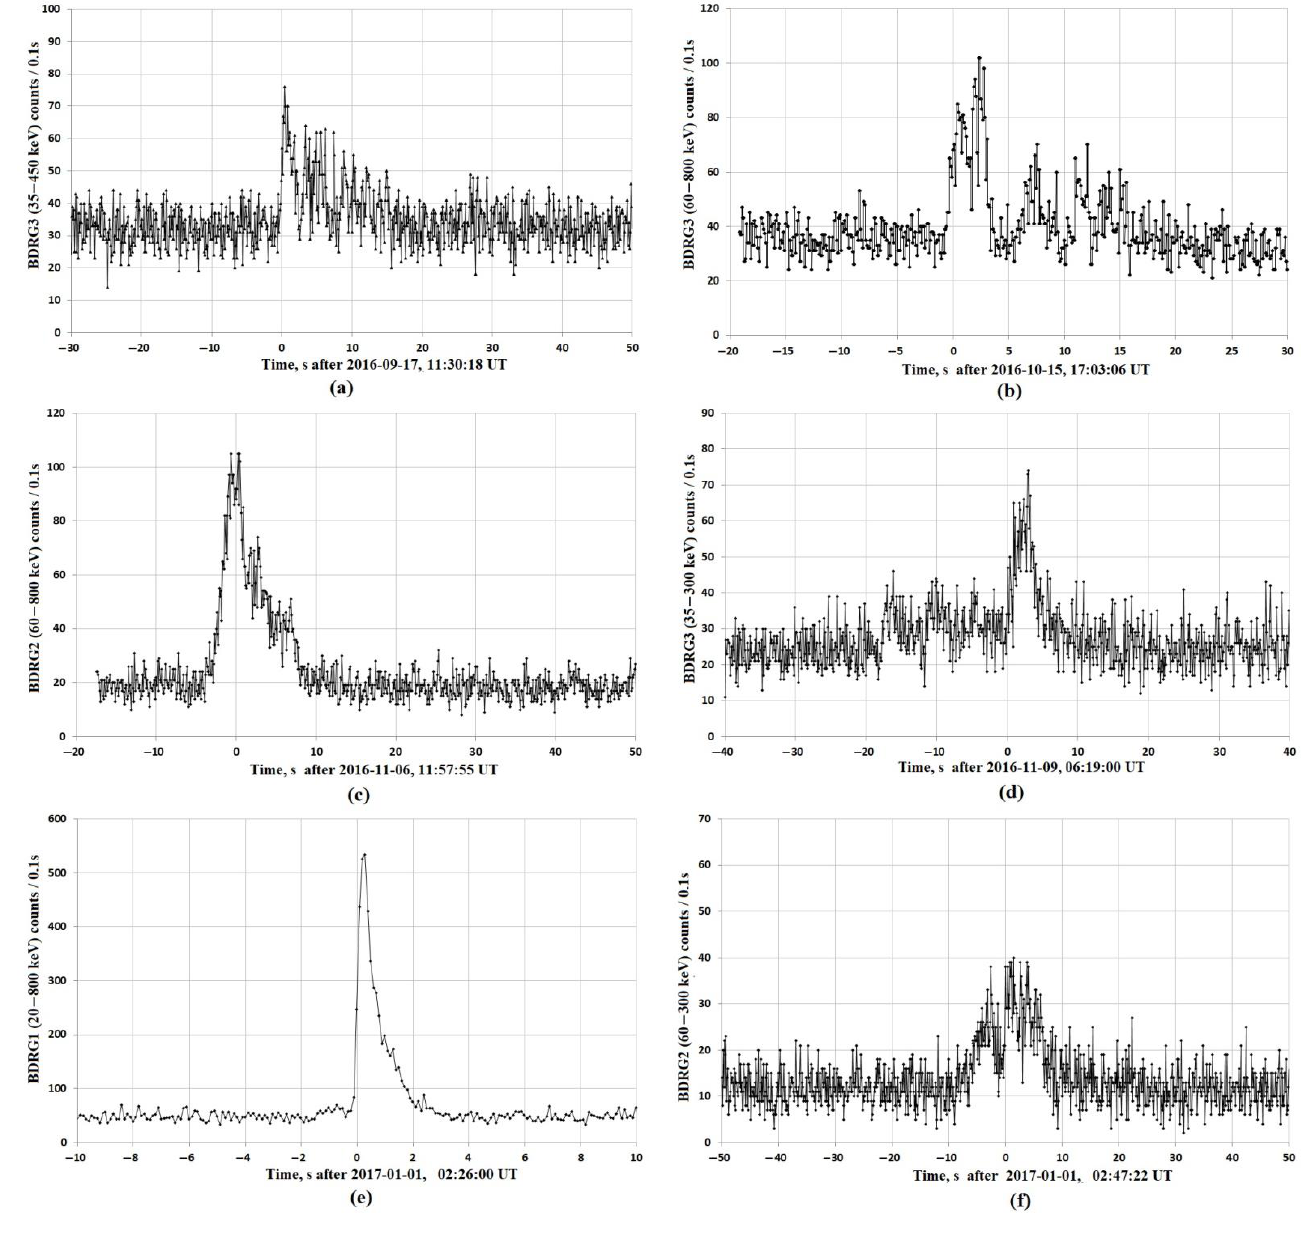
Figure 6. Light curves of BDRG/Lomonosov GRBs. ( a ) 2016 − 09 − 17, 11:30:18 UT; ( b ) 2016 − 10 − 15, 17:03:06 UT; ( c ) 2016 − 11 − 06, 11:57:55 UT; ( d ) 2016 − 11 − 09, 06:19:00 UT; ( e ) 2017 − 01 − 01, 02:26:00 UT; ( f ) 2017 − 01 − 01, 02:47:22 UT.